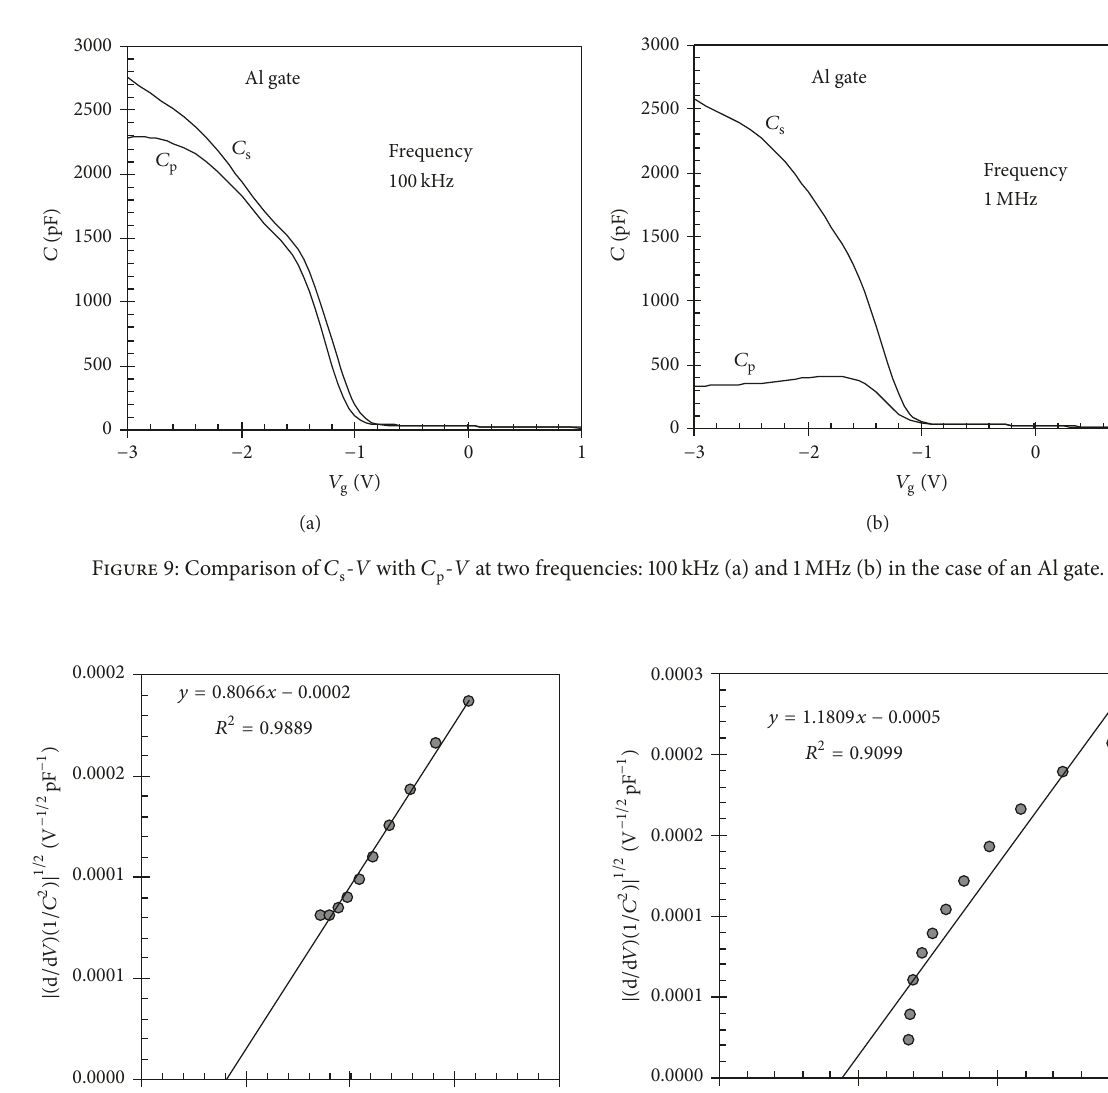
(a) and 𝐶 (b) in the case of an Al s p